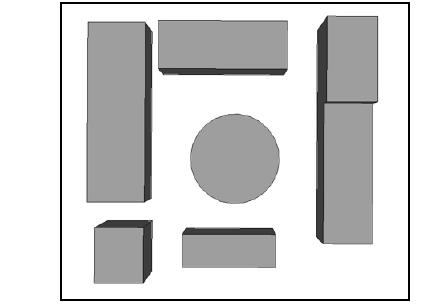
Figure 1. Top-view of the VC1 model.